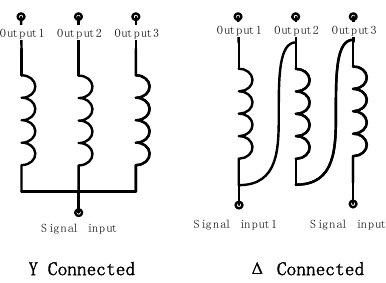
Figure 2. Simple schematic diagram of measurement method.